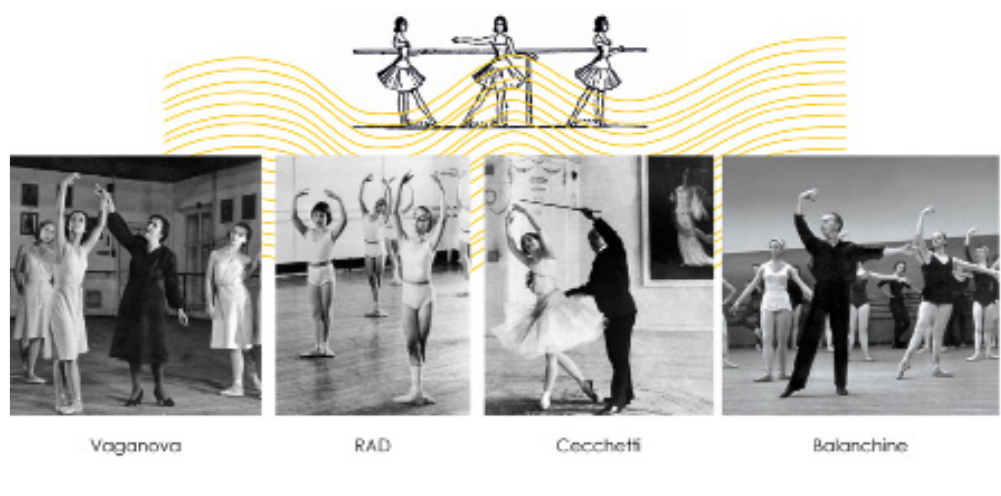
Fig. 5 Zambonini A.,